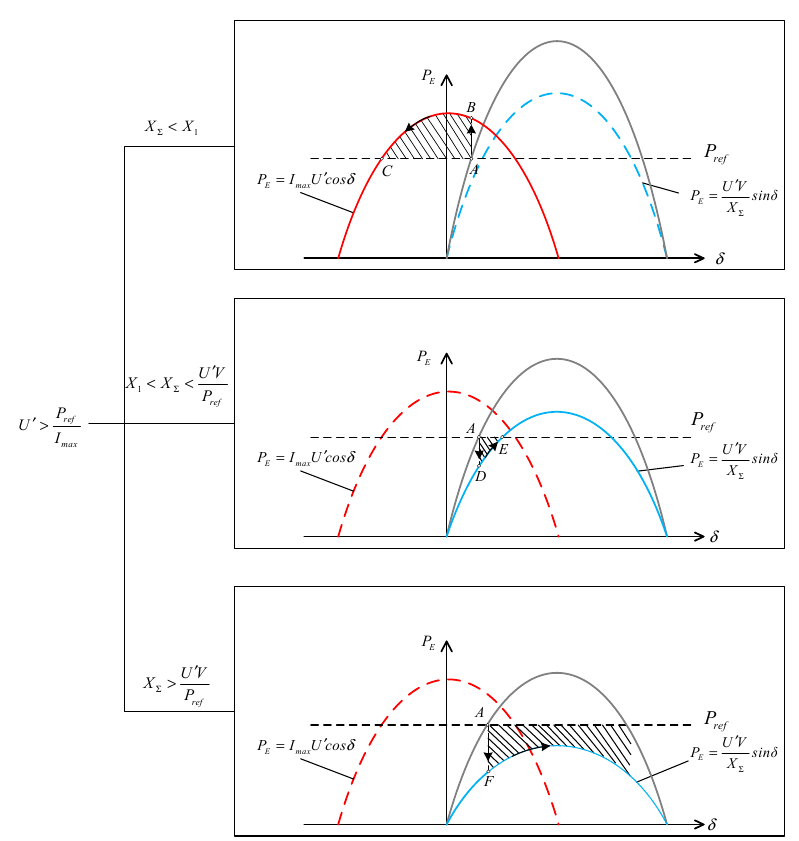
Figure 7. Power-angle curves in case of medium grid voltage sag.